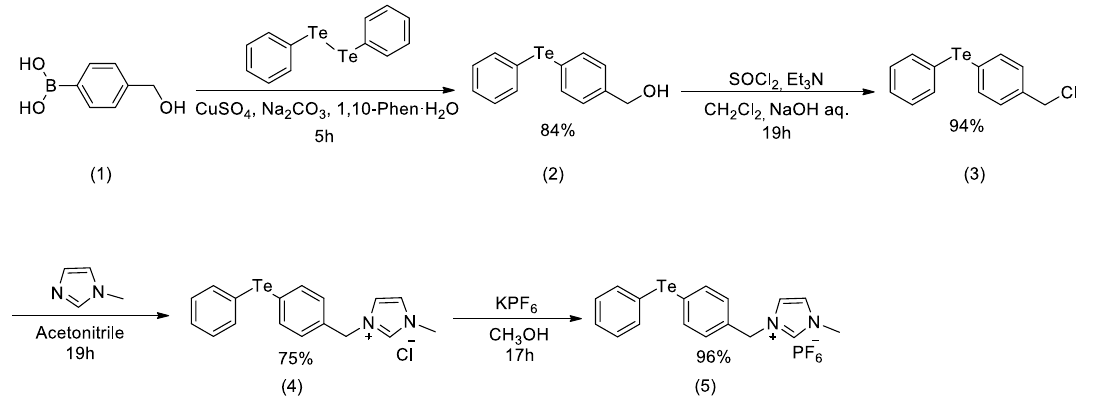
Table 1. Oxidation of thiophenol in the presence of organotellurium catalysts a